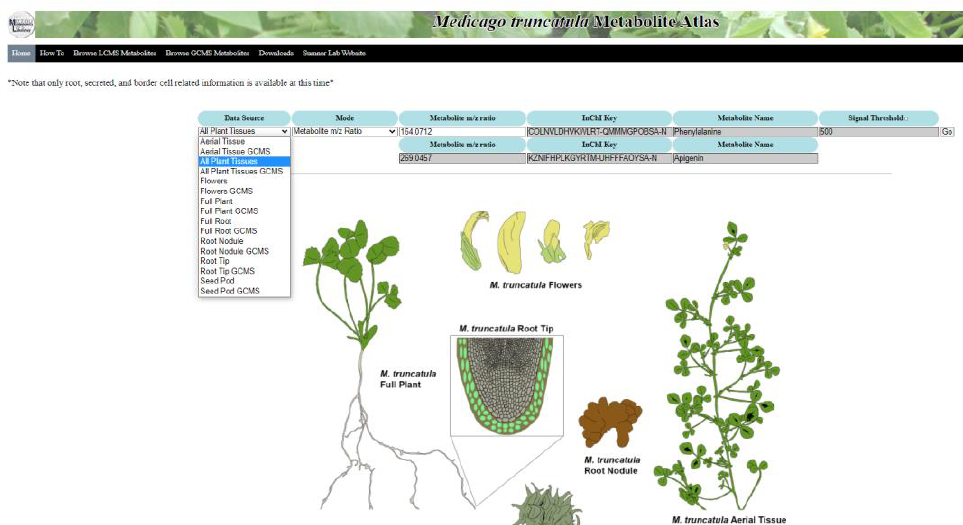
Figure 1. Comparison of UHPLC-MS chromatograms obtained for different M. truncatula root tissues (scale ×10 5 ). The Umbelliferone internal standard can be seen immediately after the 4 min time point. Observational comparison of the five sampled regions revealed differential accumulation of metabolites with the most readily apparent differences in the 0 to 2 min and 16 to 19 min time span. These qualitative data indicate differential accumulation of metabolites that can potentially be linked to specialized functions.